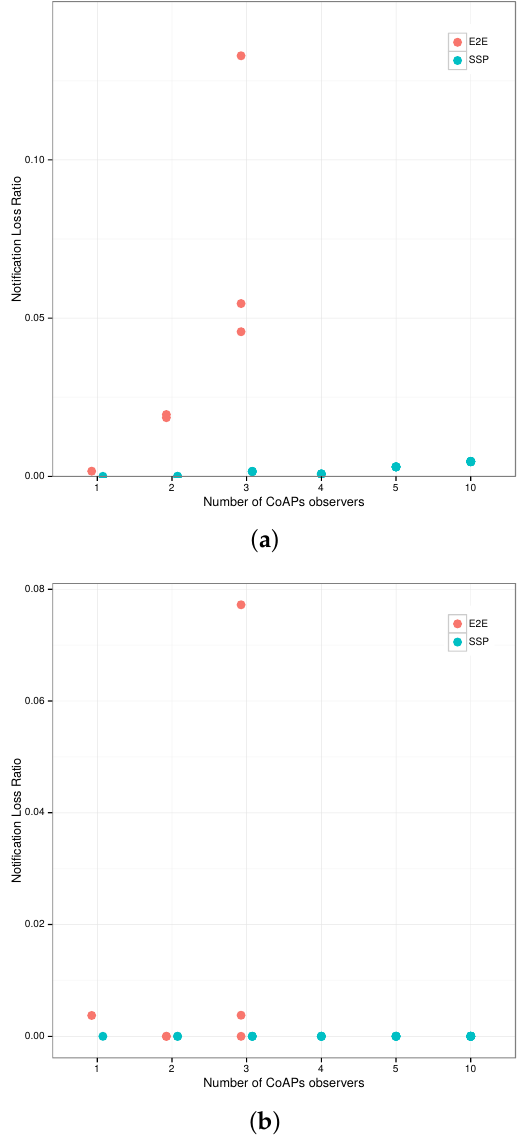
Figure 11. Notification loss ratios as measured at the CoAPs clients for E2E CoAPs observation versus CoAPS observation through the SSP. ( a ) One-second notification interval; ( b ) five-second notification